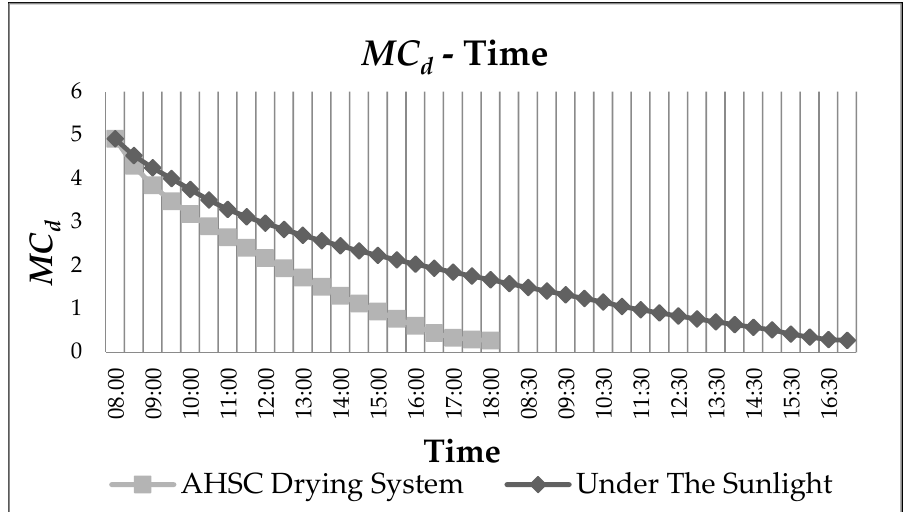
Figure 5. MC d changing with time.